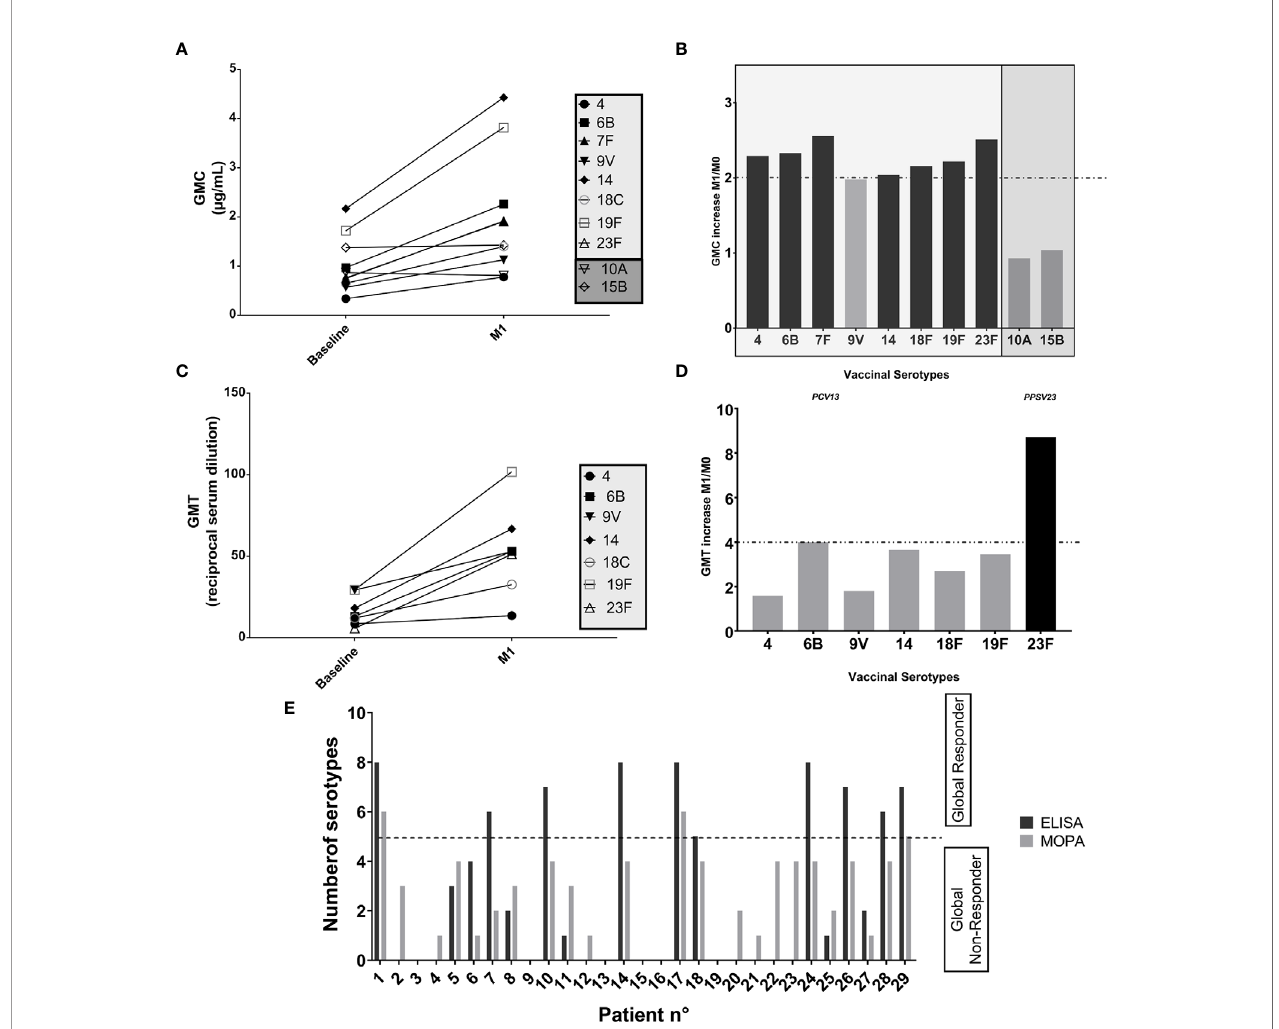
FIGURE 2 | Impact of PCV13 vaccination: evaluation of the immune response based upon ELISA and MOPA analyses toward pneumococcal serotypes, one month after vaccination. (A) Evolution of seric IgG concentrations at M1: Data are in geometric mean concentrations (GMC, µg/mL) and its 95% con fi dence limits calculated from seric IgG concentrations (ELISA) for each tested serotype. The two serotypes 10A and 15B are not included in PCV13 vaccine and are represented here as controls. (B) Response evaluated by seric IgG concentration-increase, against each tested vaccine serotype: Response toward a serotype was de fi ned as a two-fold increase from baseline in serotype speci fi c IgG concentration at one month after vaccination based on ELISA analyses (ratio of GMC at M1 and GMC at M0 for each serotype). The two serotypes 10A and 15B are not included in PCV13 vaccine and are represented here as controls. (C) Evolution of opsonization titers at M1: Data are in geometric mean titers (GMT, reciprocal serum dilution) and its 95% con fi dence limits calculated from opsonization titers (MOPA), for each tested serotype. (D) Response evaluated by opsonization titers-increase, against each tested vaccine serotype: Response toward a serotype was de fi ned as a four-fold increase in OT from baseline by MOPA at one month after vaccination. Response was de fi ned as an at least four-fold increase from baseline in OT (ratio of GMT at M1 and GMT at M0 for each serotype) based on MOPA analyses. (E) “ Global Response ” at M1: Number of serotypes for which a two-fold increase from baseline in IgG concentration (ELISA) and an at least four-fold increase from baseline in OT (MOPA) was achieved, for each patient. Patients developing a response for at least fi ve of the tested serotypes were considered as “ global responders ” to the